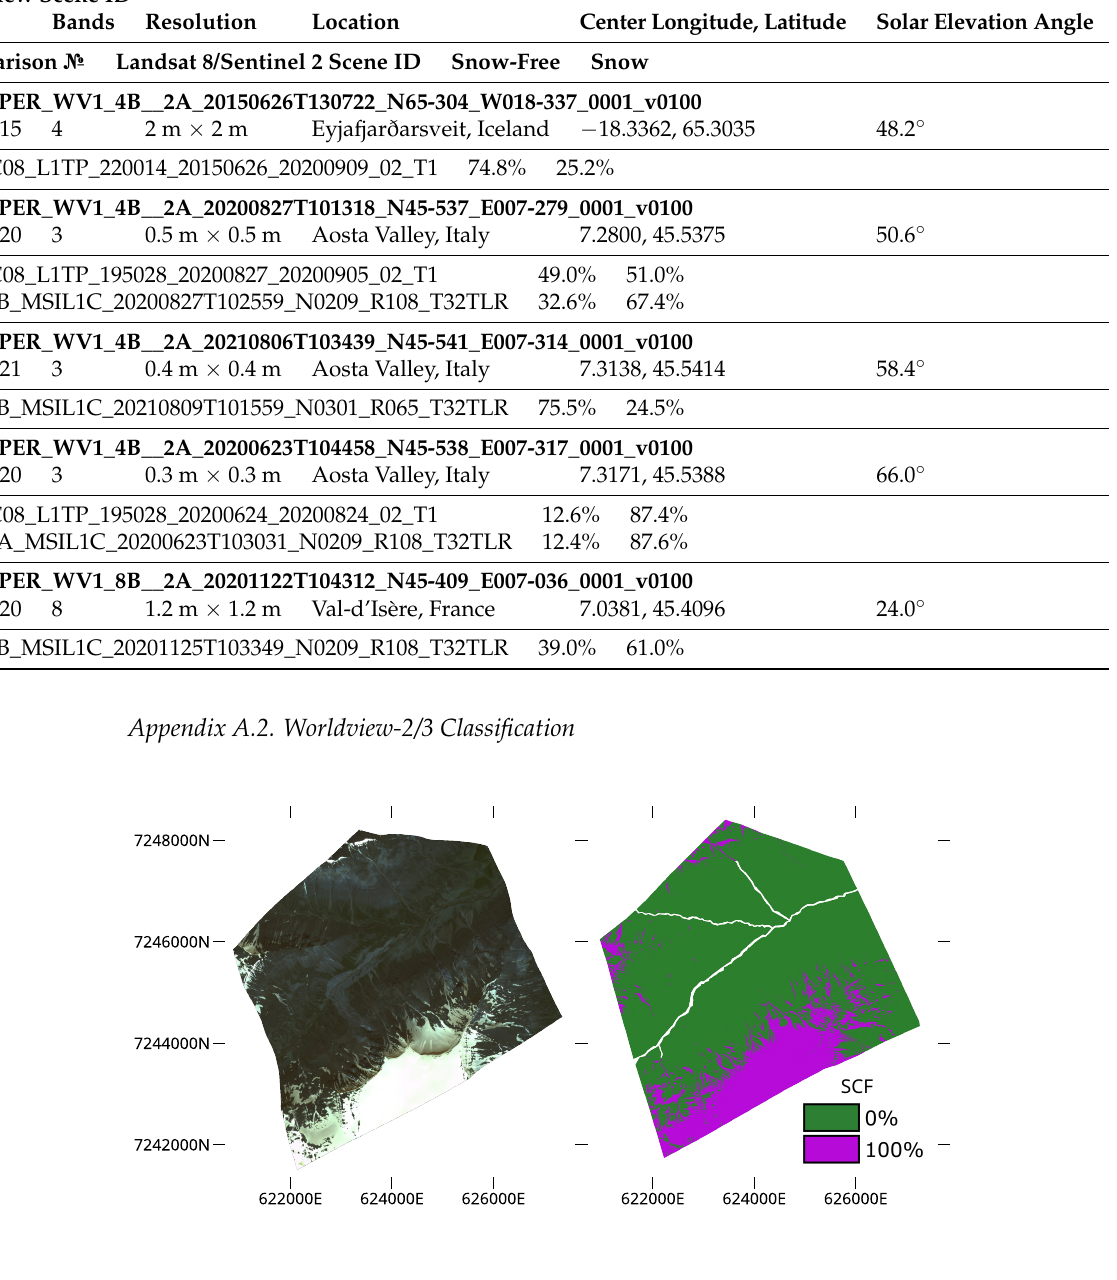
Figure A1. Left : WorldView-2 true colour composite taken on 26 June 2015 (reference № 1 in Table A2). Right : Binary snow classification of the left-side